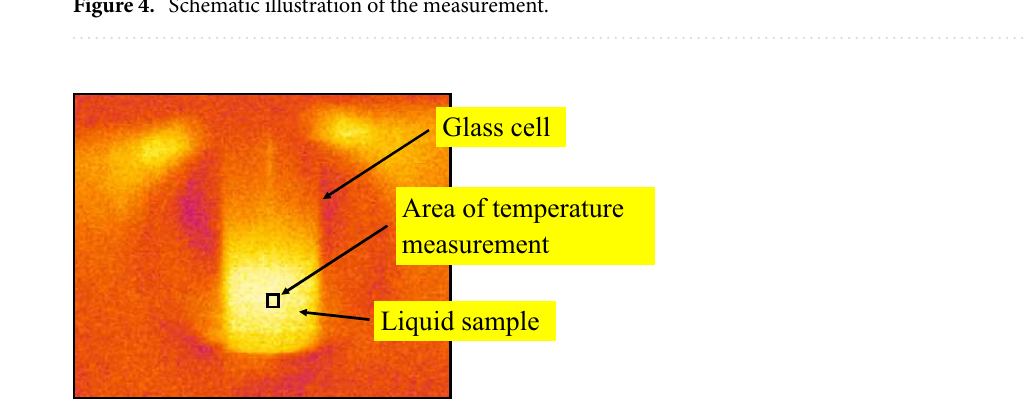
Figure 4. Schematic illustration of the measurement.